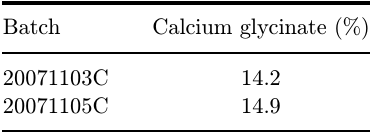
Table 2. The contents of calcium ion in calcium glycinate.